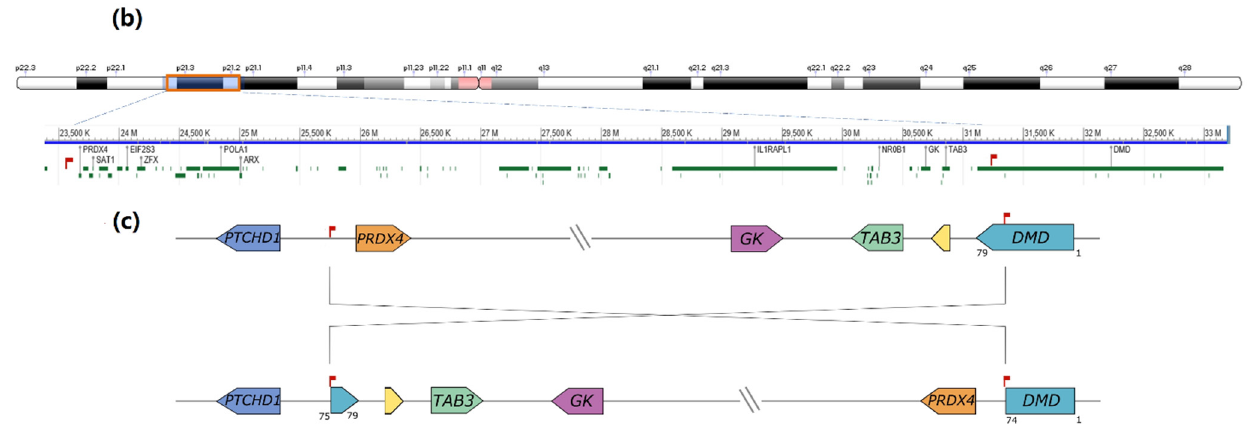
Figure 1. ( a ) Low coverage WGS results suggesting a genomic inversion. Visual BAM file inspection showed a possible breakpoint within intron 74 of DMD (1A). Some reads contained soft-clipped bases with homology with a region 48 kb upstream of the PRDX4 gene (Xp22.1). Correspondingly, some partially aligned reads in the PRDX4 region showed ho- mology with inverted intron 74 DMD sequences; ( b ) Inversion breakpoints were confirmed by Sanger sequencing. In breakpoint 2 (right) the inversion originated a 21 bp duplication (boxed in orange) and the inclusion of a short sequence with no homology to the reference genome. There was also a loss of 9 bp in DMD intron 74 and of 3 bp in the upstream PRDX4 region; ( c ) Schematic representation of the inversion at the genomic level. The inversion involves Xp22.1 to Xp21.2 (~8 Mb), comprising 74 genes. Breakpoints are localized 48 kb upstream of the PRDX4 gene (breakpoint 1) and within intron 74 of the DMD gene (breakpoint 2).